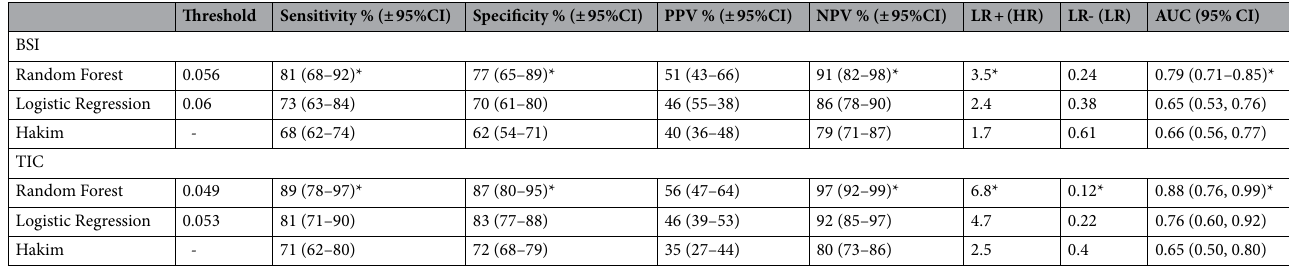
Table 3. Statical Performance of 3 prediction models for BSI and TIC. * P < 0.05 compared to the Hakim model.